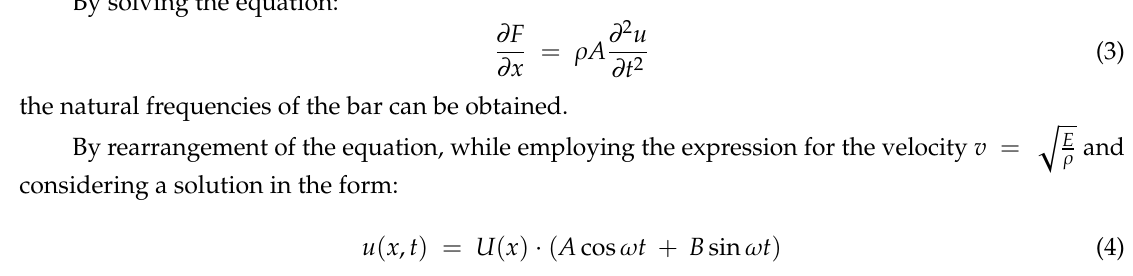
Figure 3. A segment of a bar with position of infinitesimal element.